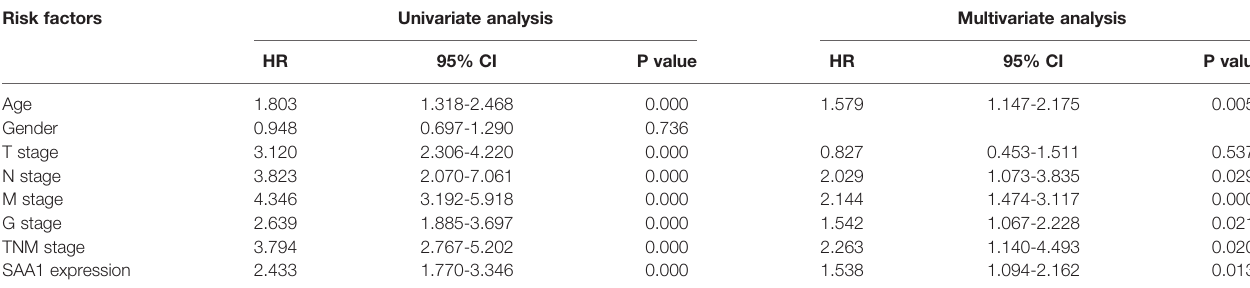
FIGURE 7 | AnalysisoftheprognosticvalueofSAA1for ccRCC.TheccRCC tissuesamplesfrom TCGAdatabase weredividedinto lowSAA1expressiongroupandhigh SAA1expressiongroupaccordingto themedianexpressionvalueofSAA1mRNAlevel.ThecorrelationbetweenSAA1 expressionandoverallsurvivaltime ofccRCCpatients wasanalyzedbyKaplan-Meier.(A-L) Overallsurvivalanalysis towards theexpressionofSAA1mRNA wasperformedinsubgroupsofccRCCpatients: (A) T1+T2 stage, (B) T3+T4stage, (C) N0stage, (D) M0stage, (E) G1+G2 stage, (F) G3+G4stage, (G) Stage I+II, (H) StageIII+IV, (I) Female, (J) Male, (K) Age ≥ 60years, (L) Age<60 years. TABLE 2 | COX regression analysis between prognostic risk factors and overall survival of ccRCC patients. Risk factors Univariate analysis Multivariate